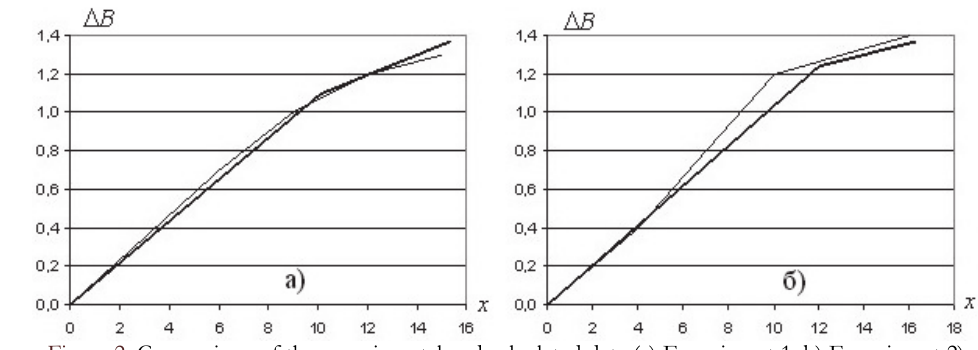
Figure 2: Comparison of the experimental and calculated data (a) Experiment 1; b) Experiment